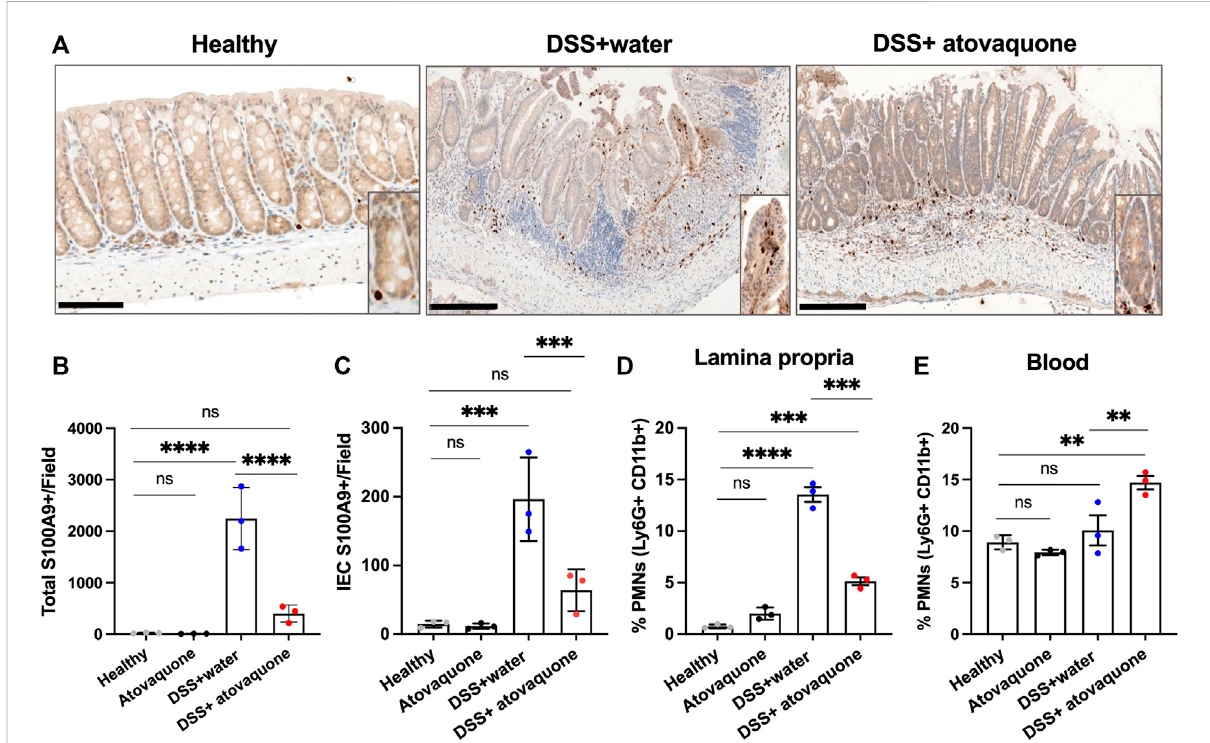
FIGURE 3 Atovaquone reduces neutrophil burden in in fl amed colon. (A) Representative immunohistochemistry (IHC) staining for neutrophil marker S100A9 of tissue sections from DSS-treated mice without (top panel) and with Atovaquone treatment (bottom panel). The bar is 100 μ m. (B) Quanti fi cation of total S100A9 positive cells per fi eld and (C) Number of intraepithelial S100A9 positive cells (cells that are in direct contact with theepithelialcrypts).Atleast20 fi eldspercondition(shownasaveragedvalue)from3independentexperimentswerequanti fi ed. (D) Analysesof neutrophil numbers by fl ow cytometry within the digested colon lamina propria and (E) Peripheral blood of DSS-treated mice with/without atovaquonetreatment.DataareshownaspercentofLy6G/CD11bpositiveneutrophilsoutoftotalcells.N=3independentrepeats.** p < 0.01,*** p < 0.001, **** p < 0.0001, ns, not signi fi